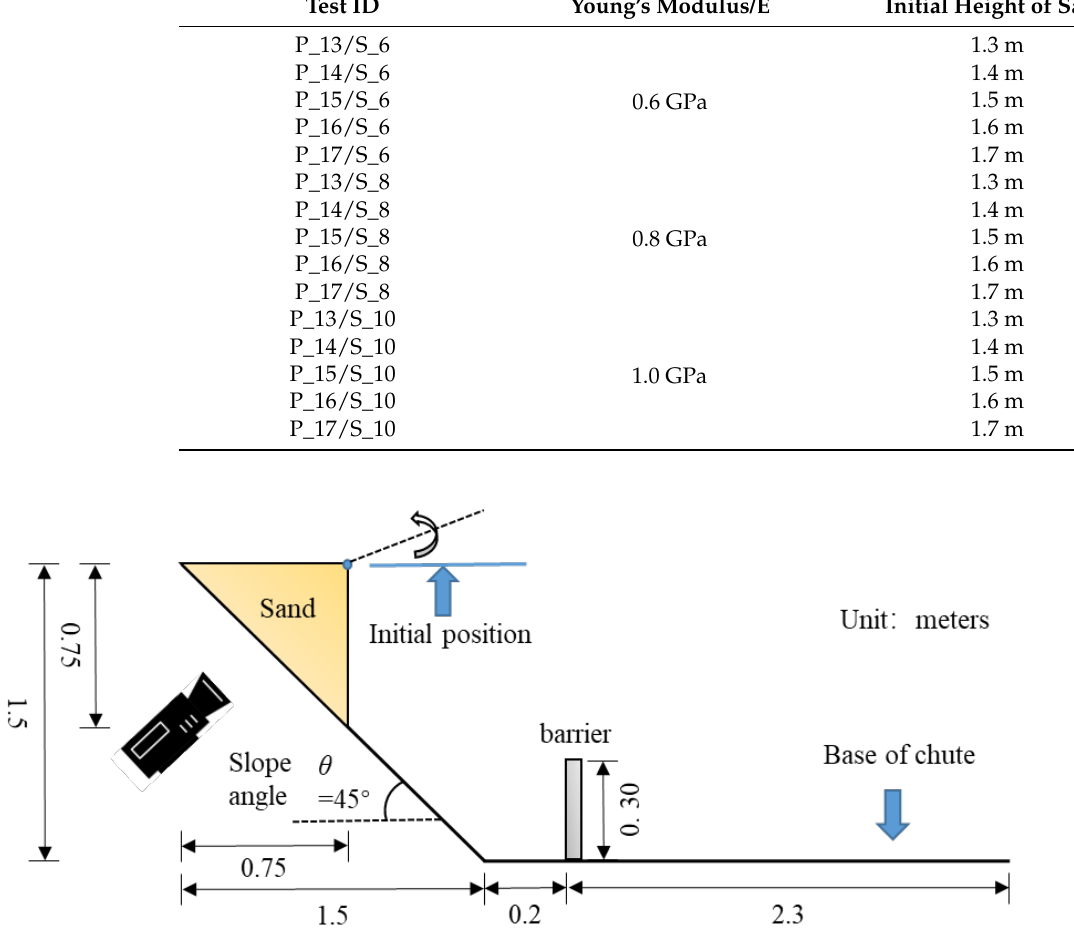
Figure 2. Sketch of the simulated flume model. Table 1. Key input parameters of simulation.